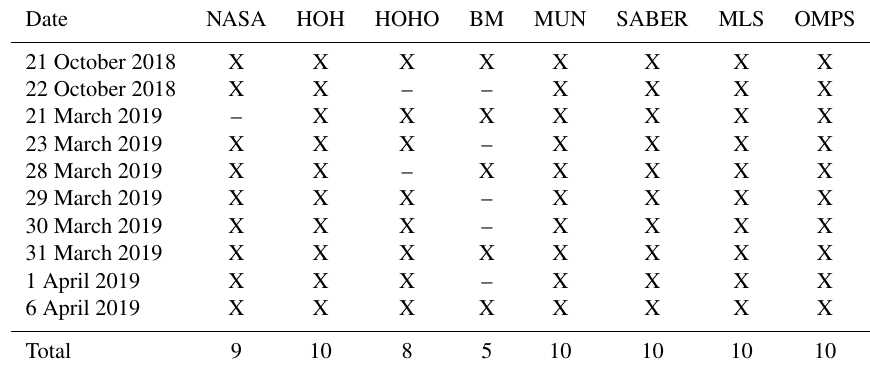
Table 2. Measurement dates for all instruments during the HOPS campaign in October 2018 and March 2019. The dates are taken at the UT start time of the lidar measurements. X denotes a valid measurement for the given night.